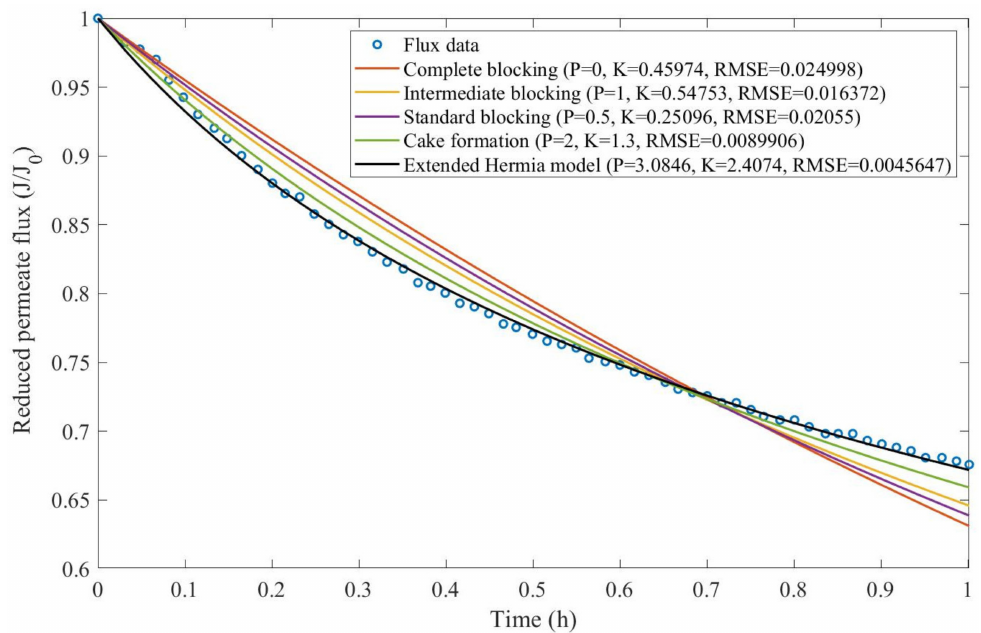
Figure A4. Model fitting for MIEX 12 mL/L + Coagulant 40 mg/L + HPI ultrafiltration considering the four original pore-blocking mechanisms and the extended Hermia model (14).